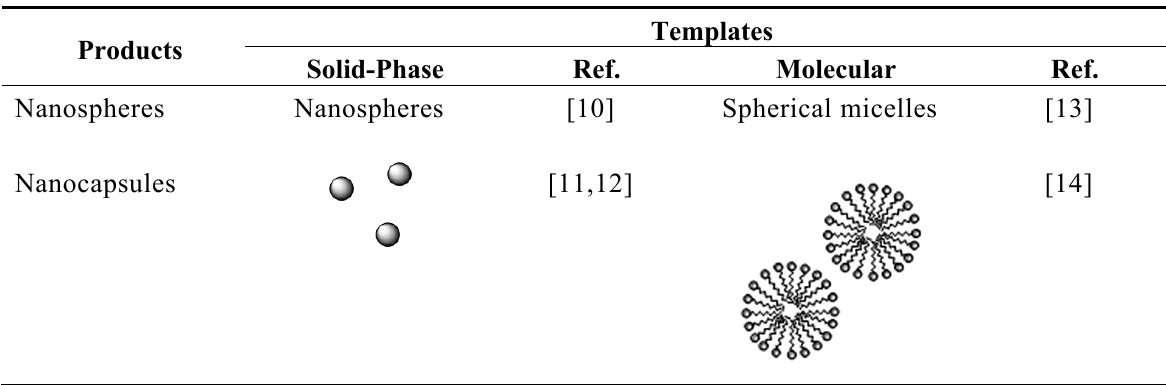
Table 2. Template synthesis